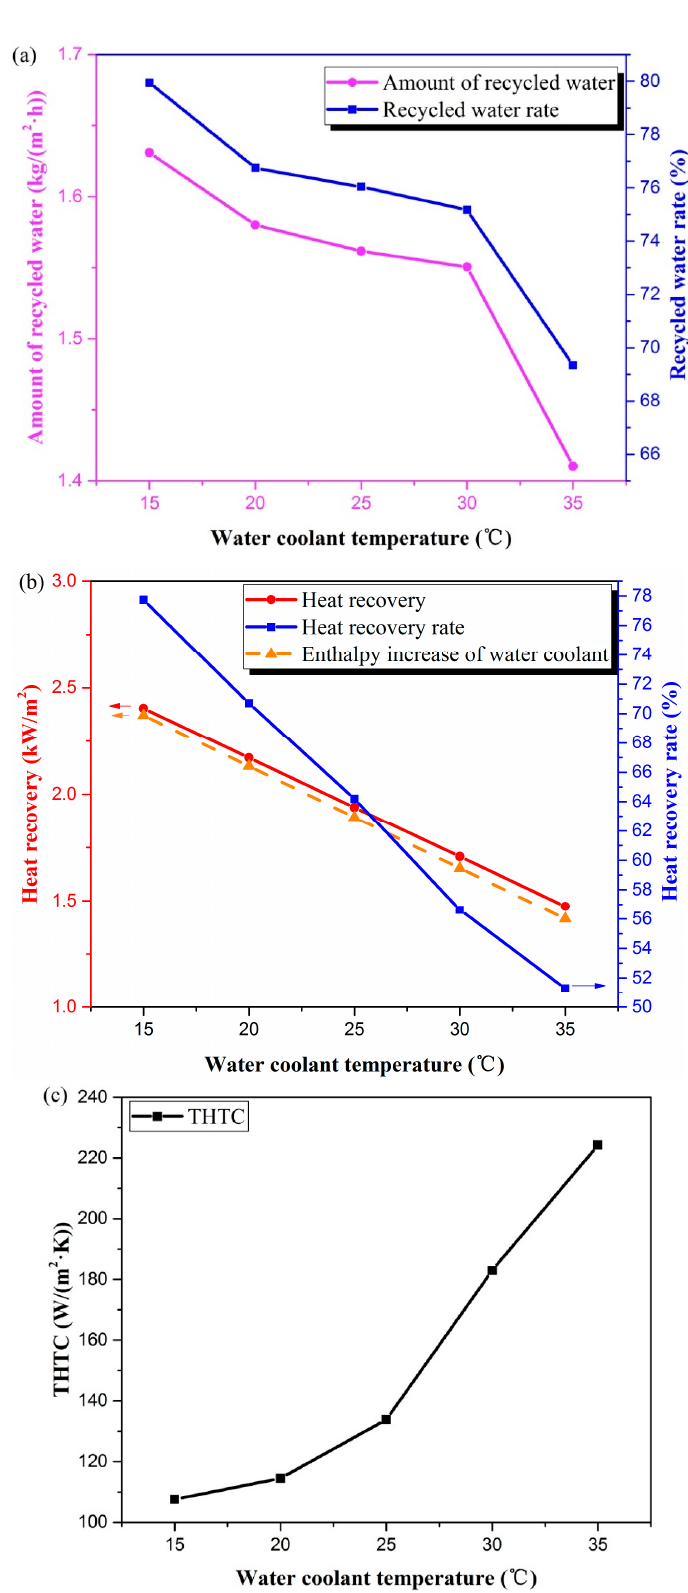
Figure 7. Effect of water coolant temperature in terms of ( a ) water, ( b ) heat, and ( c ) THTC . (Experimental conditions: flue gas flow rate 1.875 × 10 − 4 kg/s, flue gas temperature 50 °C, water coolant conditions: flue gas flow rate 1.875 × 10 − 4 kg / s, flue gas temperature 50 ◦ C, water coolant flux flux 1.664 × 10 − 2 kg/s). 1.664 × 10 − 2 kg /